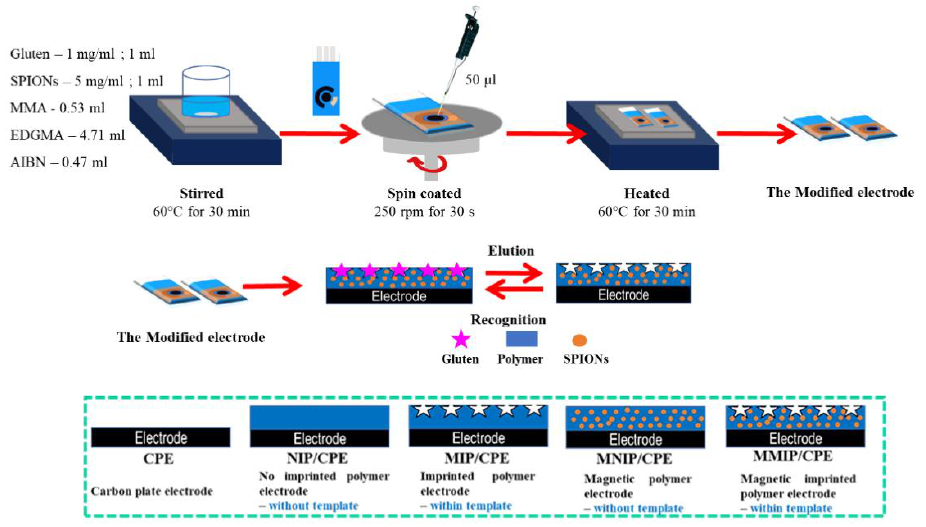
Figure 19. Scheme of the MMIP sensor assembly and the corresponding gluten detection strategy. Reprinted from [181].